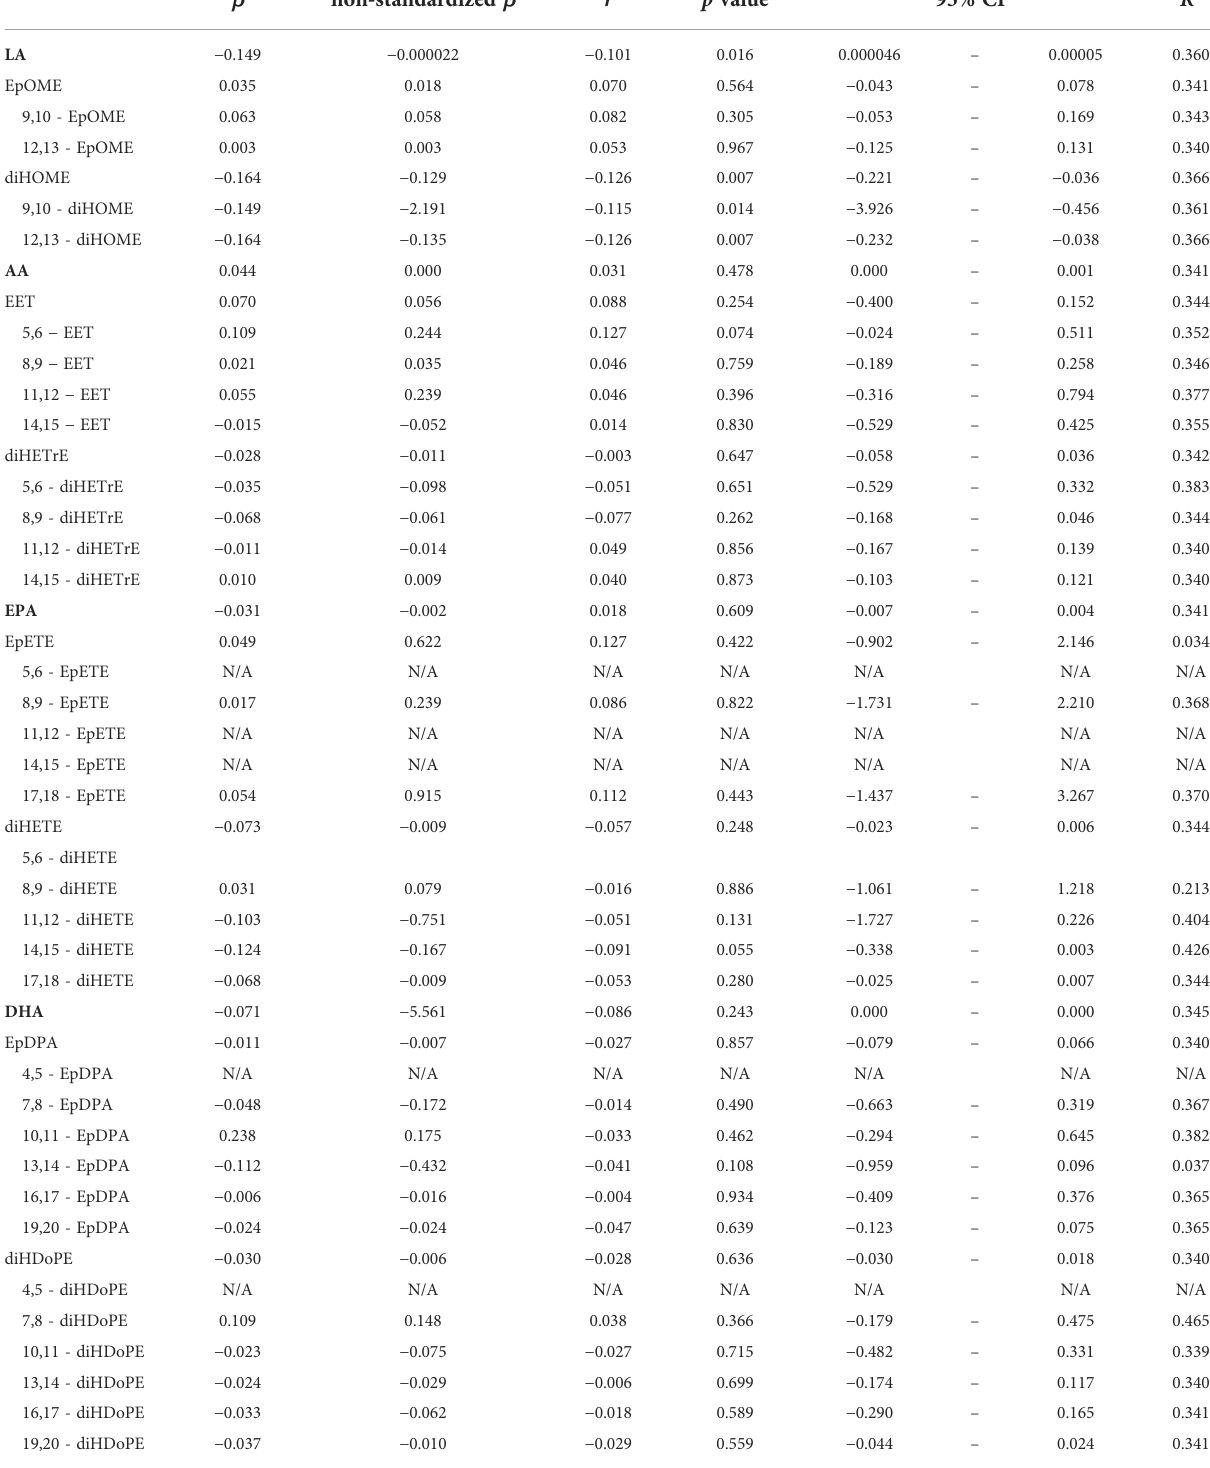
TABLE 7 Correlation between birth weight and PUFA metabolite in cord blood after adjustment for potential confounding